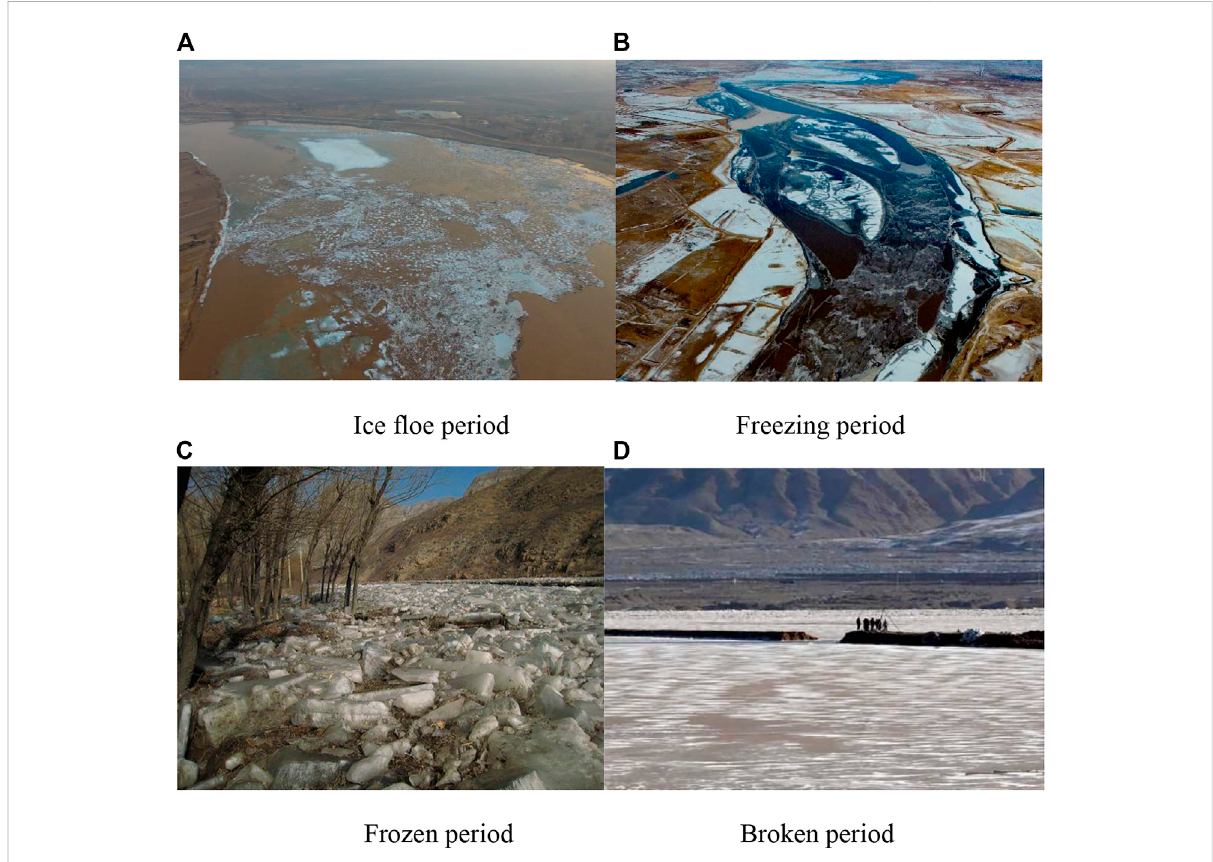
FIGURE 1 Ice jam during the stable sealing period of the Yellow River in China. (A) Ice pans ( fl oe) fl oating period, (B) Freeze-up period, (C) Ice-covered/ jammed period, and (D) River break-up